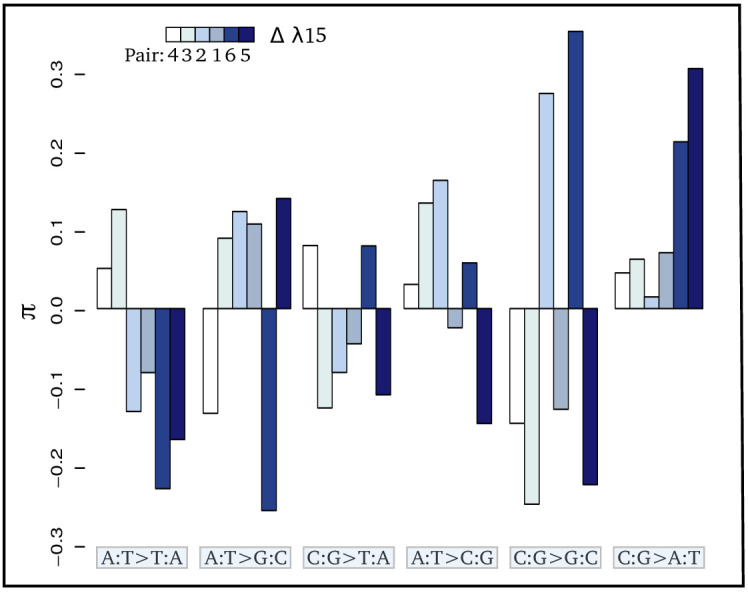
Contrasts (π) of the relative proportion of each mutation [p(i:j→k:l)] in each pair of sister species: πm=logp(i:j→k:l)+p(i:j→k:l)− where + and - refer respectively to the species exposed to the higher and lower level of radioactivity in the pair m.Thus, positive bars represent a higher proportion of the given mutation in the species living in the high radioactivity rock. From left to right, bars are in increasing order of difference (Δ) in λ15 (the areal proportion of igneous and metamorphic rock in a radius of 15 km around the site) between the two species of each pair. From left to right, mutations are in increasing order of correlation with radioactivity. Numbers below the color scale indicate the species pair number as in Figure 1.